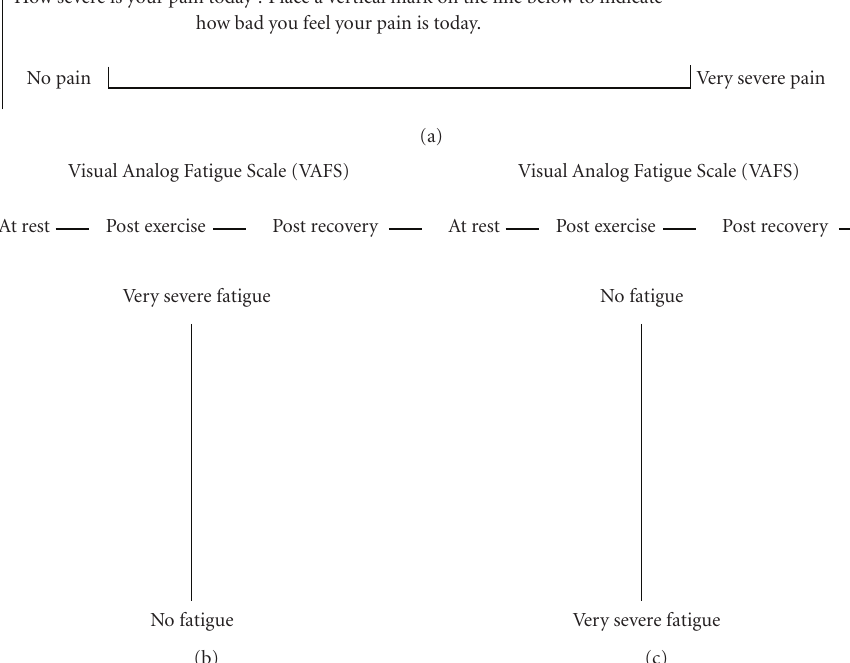
Figure 1: Illustration of (a) traditional visual analog scale used to measure pain, (b) VAFS version 1, and (c) VAFS version 2. VAFS: Visual Analog Fatigue Scale.